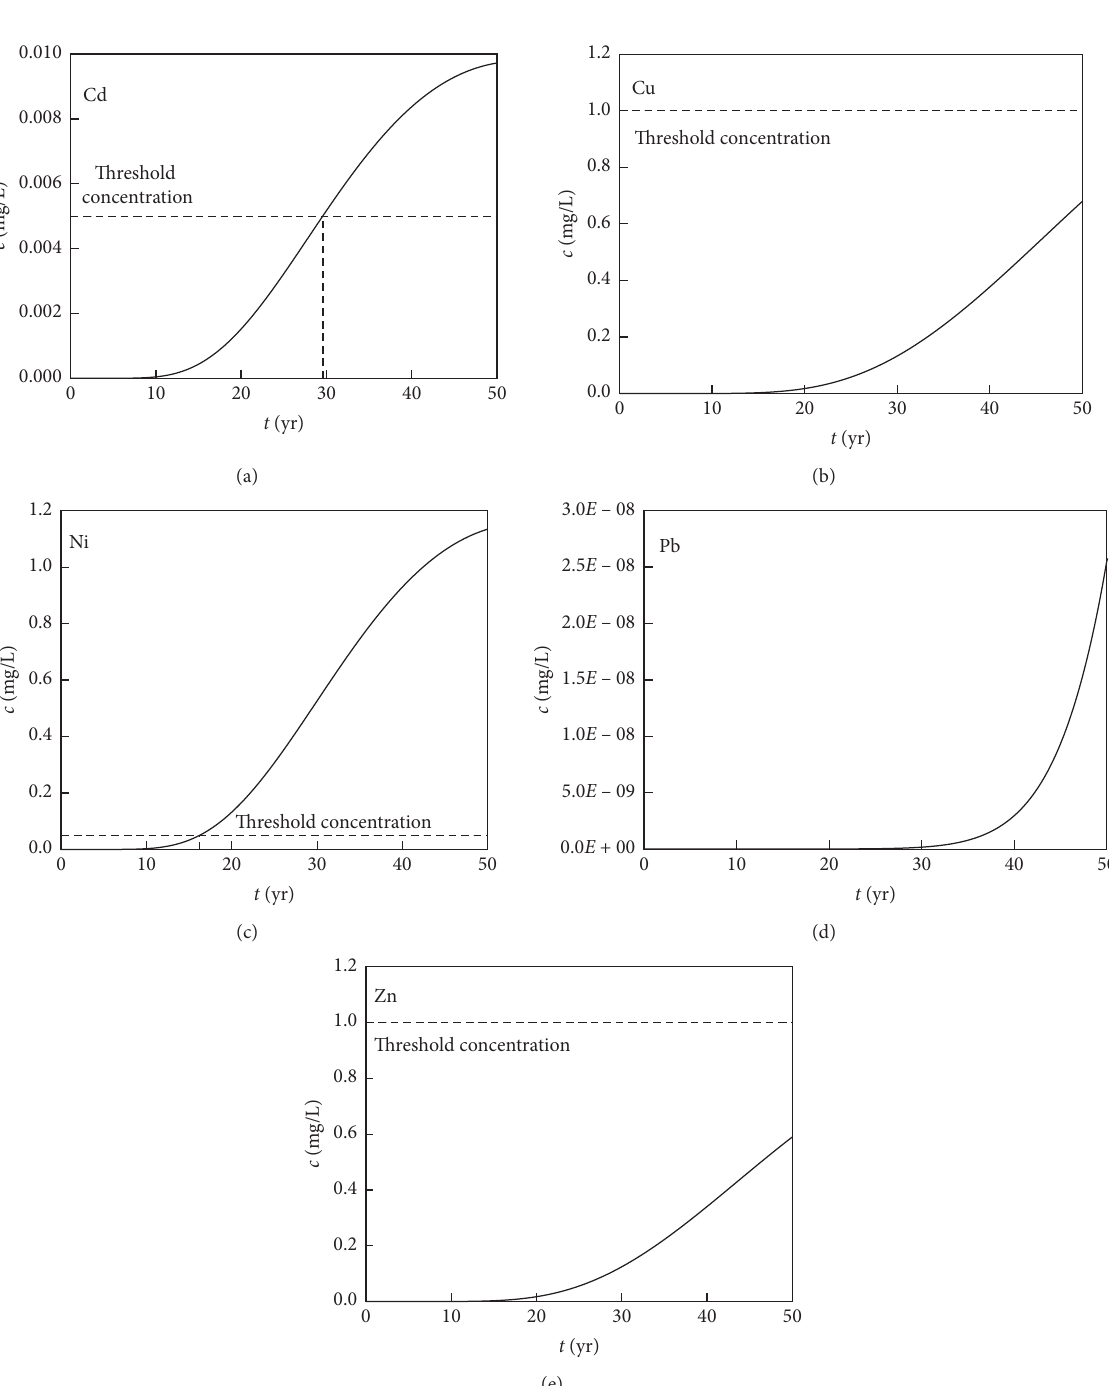
Figure 6: Breakthrough curves of various heavy metal pollutants in the sludge landfill. (a) Cd, (b) Cu, (c) Ni, (d) Pb, (e)